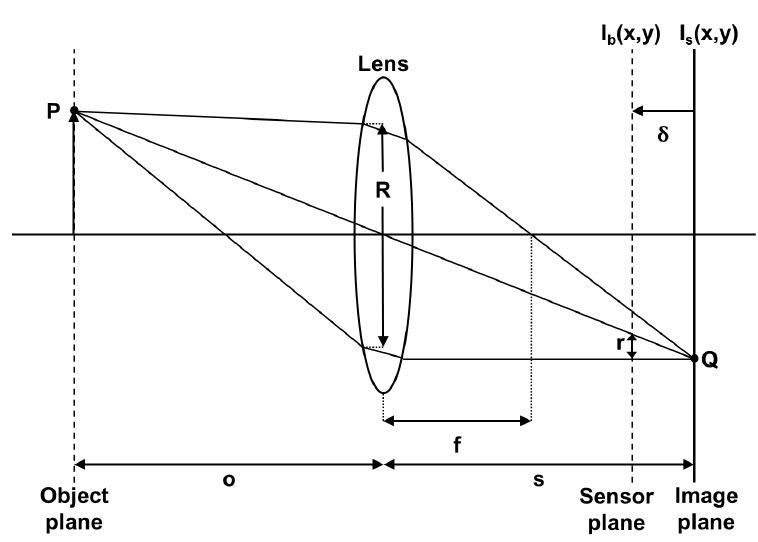
Figure 1. Sharp and unsharp image